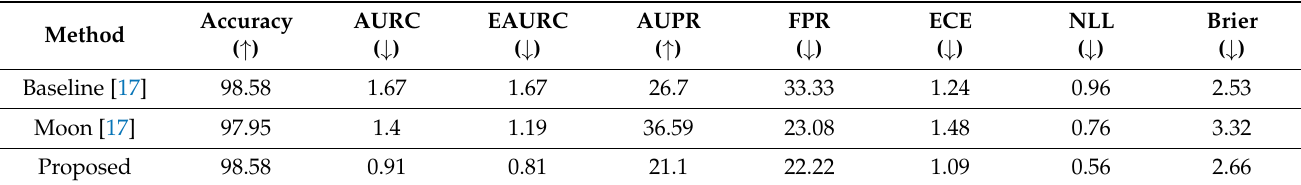
Table 2. Comparison of